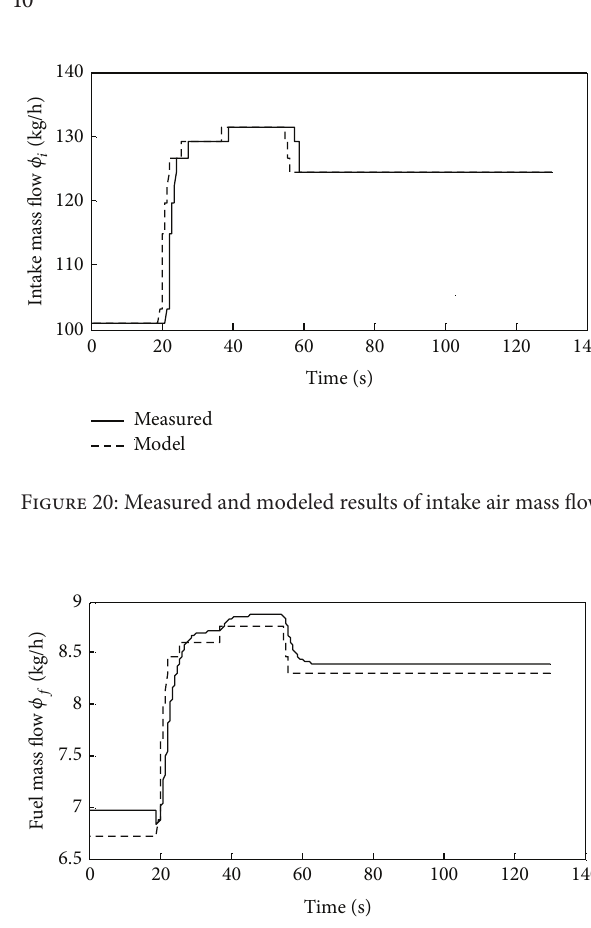
phase, but, in stable phase, the estimation error is 0.11, about 1.3%. The boost pressure and intake manifold pressure results shown in Figures 22 and 23 have the same characteristics with fuel mass flow.